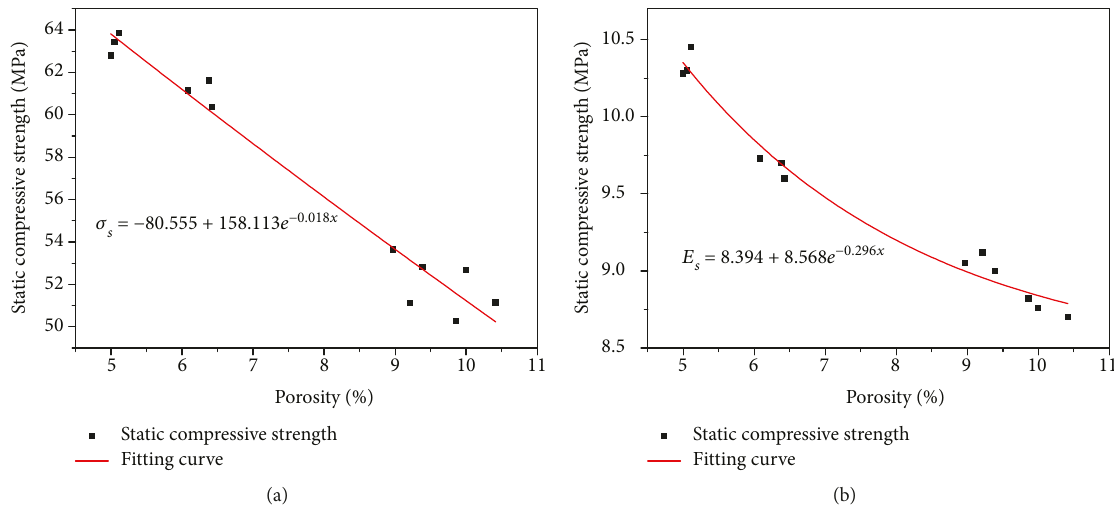
Figure 8: Relationship of porosity and static mechanical